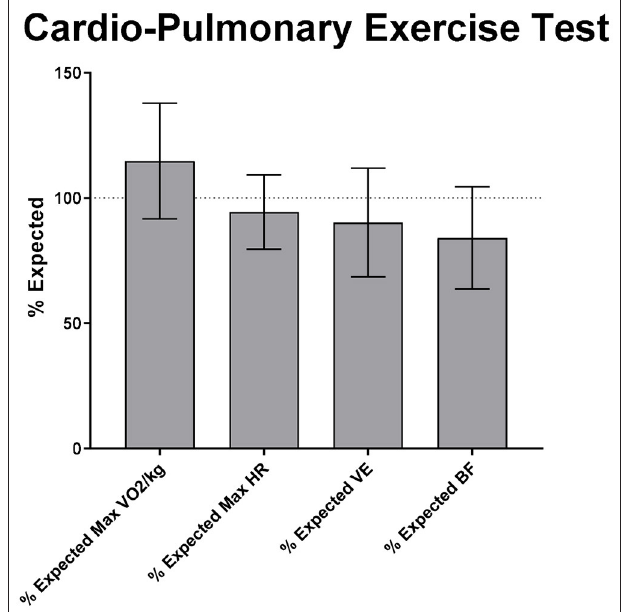
FIGURE 2 | Cardio-pulmonary exercise test results as % expected for the patients’ age, sex and ethnicity. HR, heart rate; VE, minute ventilation; BF, breathing